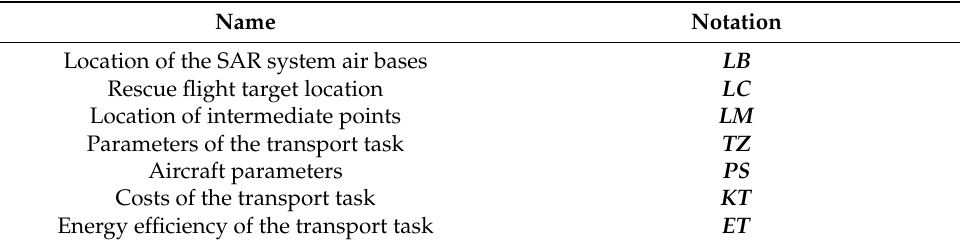
Table 3. Data identification for a mathematical